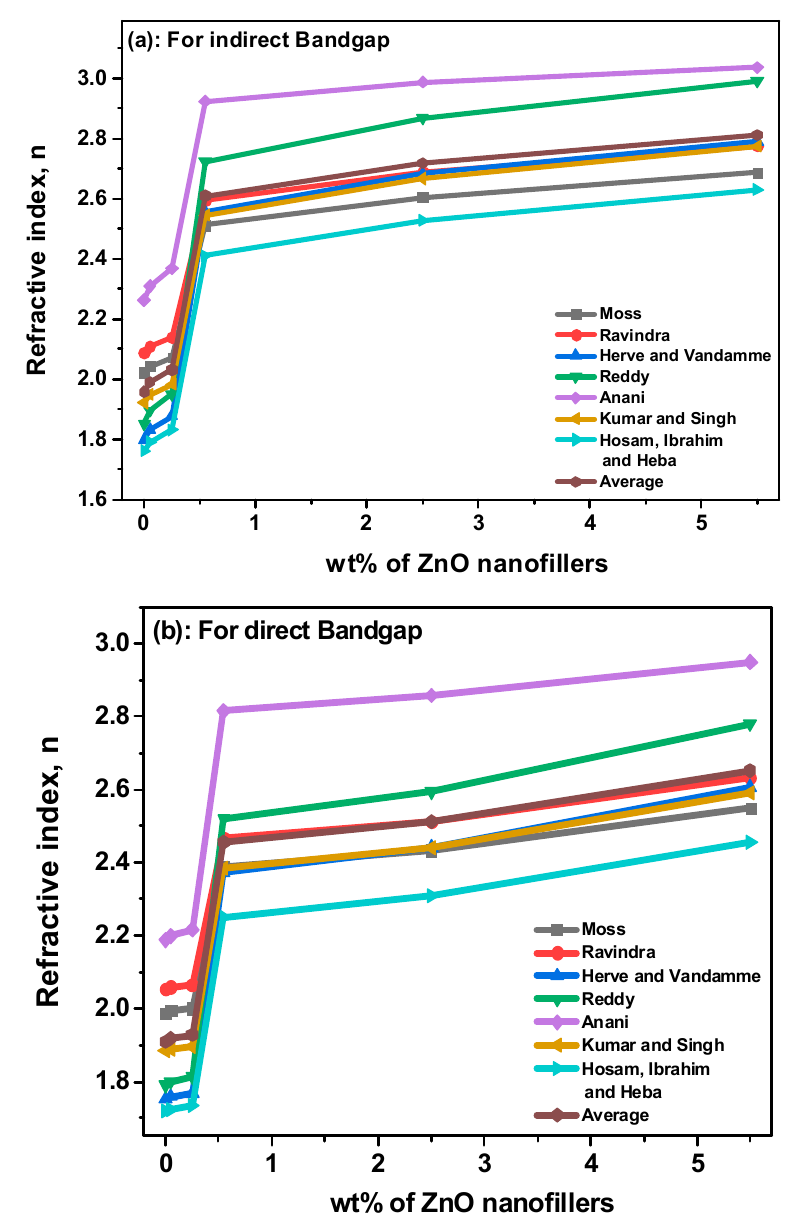
Figure 7. ( a , b ): The refractive index of different models from the indirect and direct energy bandgap is the ZnO doped in PVA/PVP polymeric nanocomposite films. as a function of the direct and indirect bandgaps for the ZnO NPs-doped PVA/PVP blend polymeric films. The integrated values of the nonlinear susceptibilities and nonlinear refractive index firmly establish a similar attitude. Further analysis suggests that the supreme values of χ ( 1 ) susceptibilities are 155.85 × 10 − 13 esu. The utmost nonlinear refractive index value is 20.87 × 10 − 11